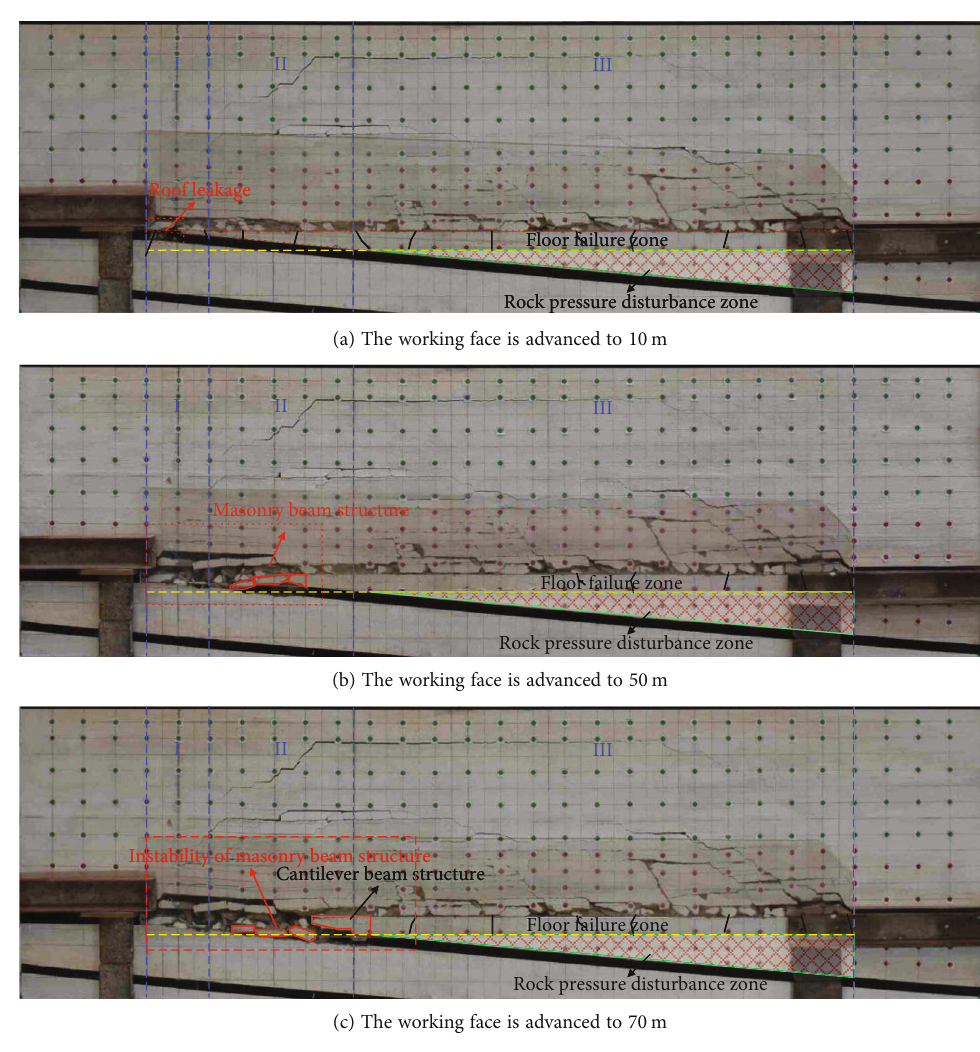
Figure 12: Schematic diagram of overburden fracture formation during 70m advancement of the no. 7-2 coal